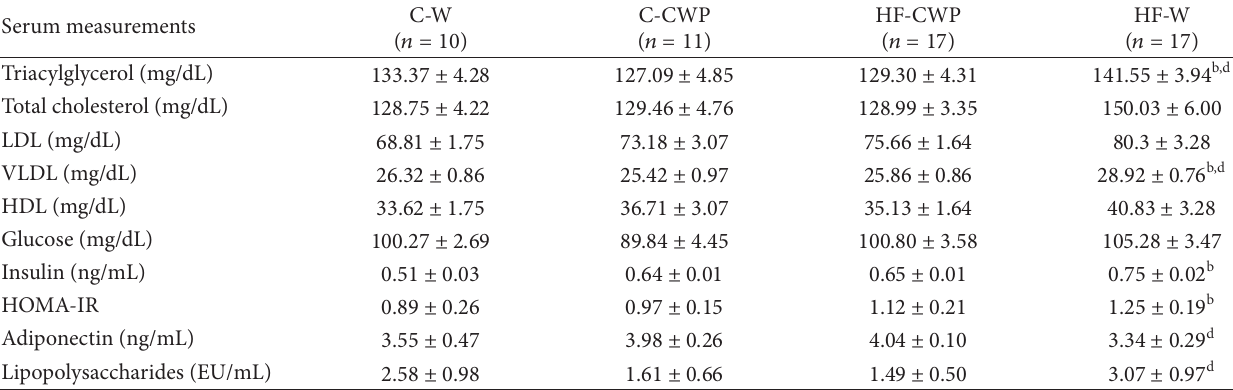
Table 5: Concentrations of IL-6, TNF- 𝛼 , IL-10, and IL-10/TNF- 𝛼 (pg/mg of total protein content) in different experimental groups. C-W C-CWP HF-CWP HF-W ( 𝑛 = 6 ) ( 𝑛 = 7 ) ( 𝑛 = 12 ) ( 𝑛 = 12 ) IL-6 329.69 ± 43.64 132.08 ± 24.10 a 215.80 ± 49.70 241.61 ± 29.27 TNF- 𝛼 111.93 ± 21.71 92.60 ± 22.86 54.48 ± 8.27 69.38 ± 17.35 IL-10 153.36 ± 27.01 119.30 ± 29.04 65.05 ± 9.96 100.74 ± 20.97 b IL-10/TNF- 𝛼 1.37 ± 0.027 1.28 ±